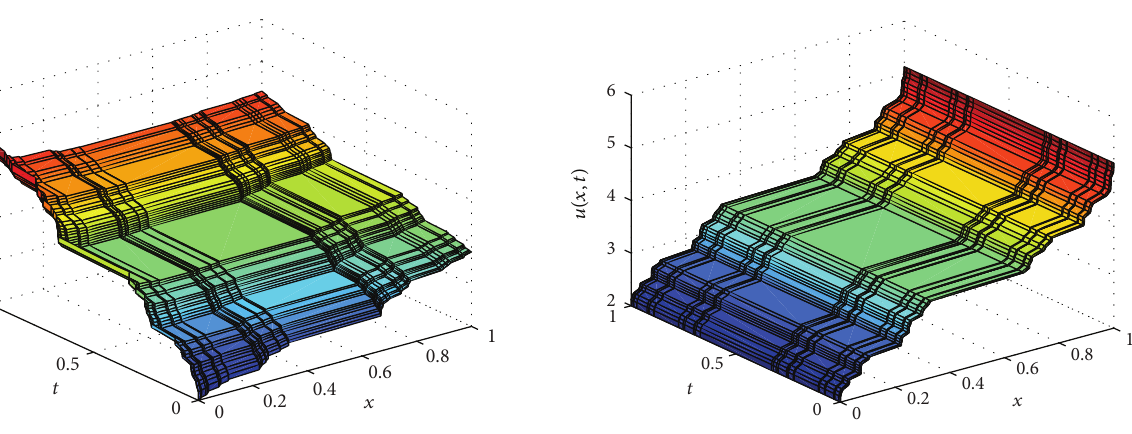
Figure 2: Graph of 𝑢(𝑥,𝑡) with the parameter 𝛼 = ln 2/ ln 3